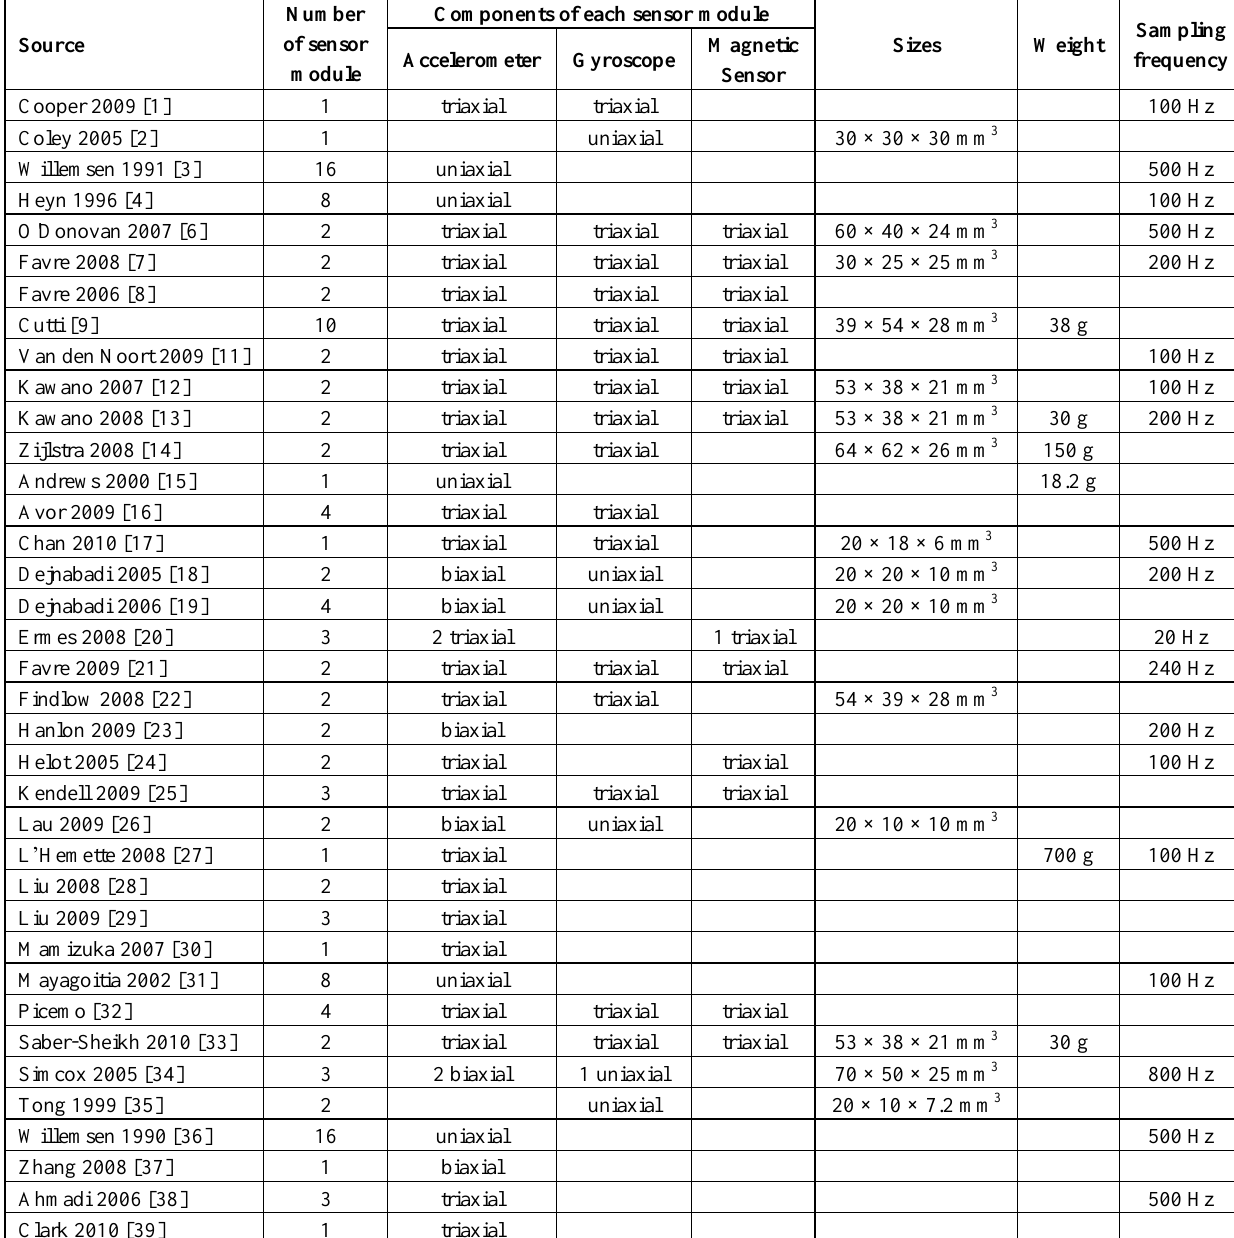
Table 1. Type of sensors adopted in reviewed